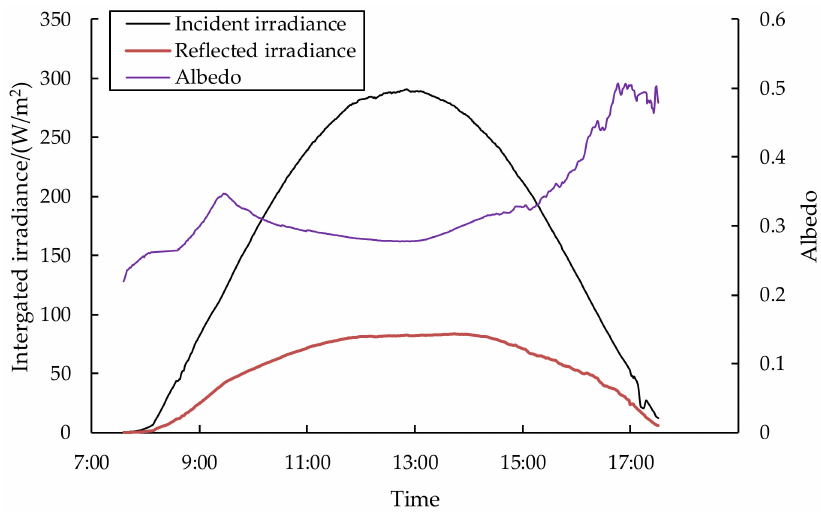
Figure 2. Daily variation of incident and reflected irradiances, and ice surface albedo, on 22 January. Figure 3 shows the typical curves of diurnal changes in the ice surface albedo under five different weather conditions. It was sunny on 22 January, but the ice surface albedo was not always the highest at any time compared with the other curves. The curve was smooth and had less noise. The calculated sunrise, solar noon, and sunset times in Beijing time are given in Table 2. The albedo–time curve had two peaks occurring in the morning and afternoon. The first occurred approximately 1.5 h after sunrise, with a solar altitude of 13.1–14.4 ◦ , whereas the second occurred roughly 0.8 h before sunset, with a solar altitude of 4.8–8.9 ◦ . The two peak values were quite different, exhibiting an obvious asymmetric characteristic. The trough on the curve occurred approximately in the middle of the day, with a solar altitude angle ranging from 28.7 to 32.5 ◦ . Taking solar noon in Beijing time (12:00) as the axis of symmetry, the curve is also asymmetric, with a different length from the peak to the symmetry axis due to the time difference between local time and Beijing time. Therefore, the albedo curves have an M shape from sunrise to sunset.